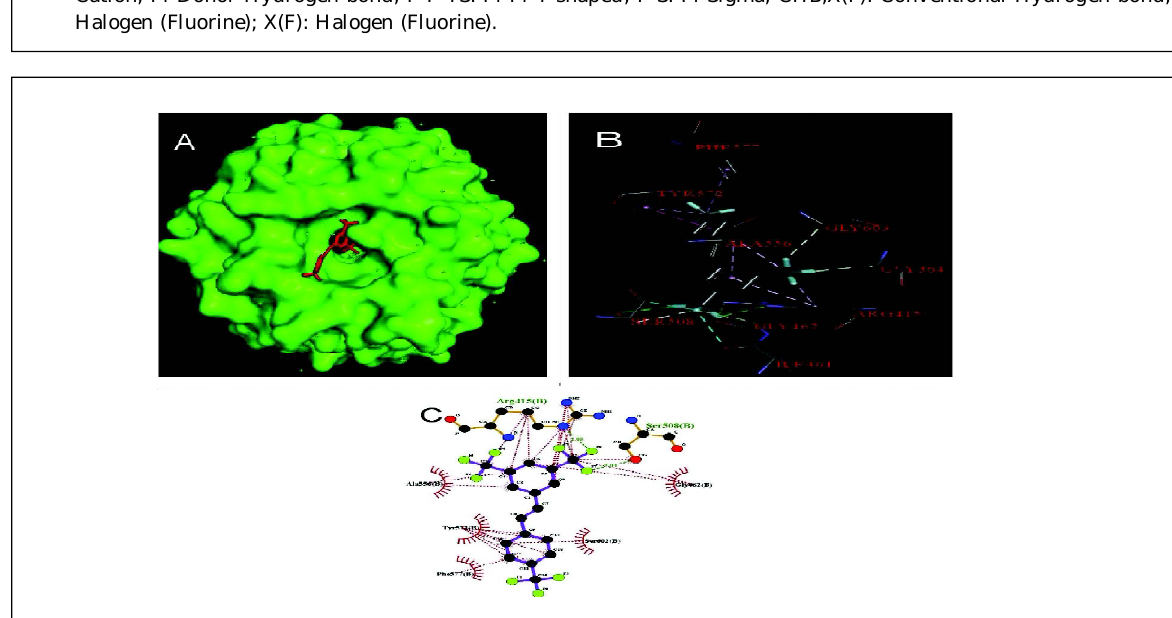
Figure 9: The pictorial illustrations for the Resveratrol-4 derivative in the Kelch domain (PDB: 4L7B), including the surface view of the top-ranked docked pose (A), interaction analysis from Accelrys discovery studio (B) and the same from LigPlot